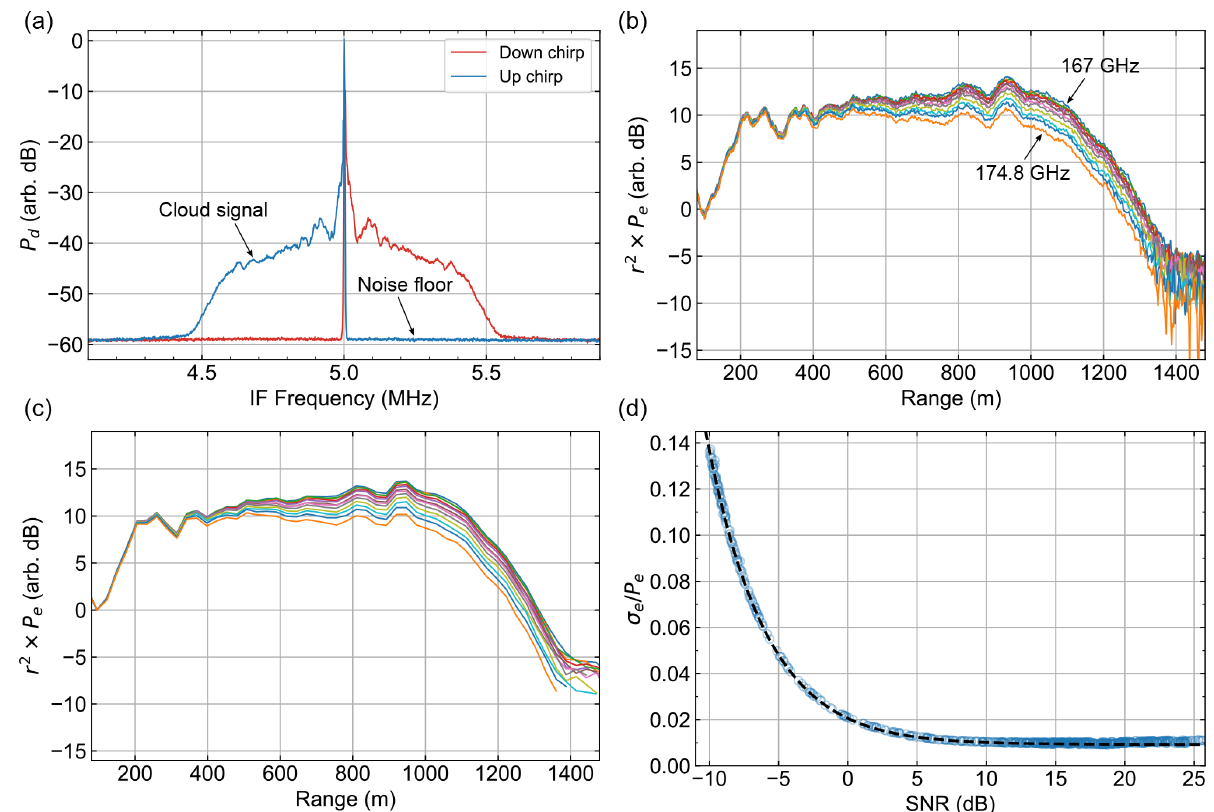
Figure 4. DAR measurement spectra. (a) The bidirectional frequency chirp technique provides for accurate, real-time characterization of the background noise floor within the radar’s IF band, with no loss of measurement duty cycle. Here the detected power spectrum for f j = 167GHz is shown. The IF frequency to range conversion factor is 400kHzkm − 1 . (b) Echo power spectra normalized to their value at 100m for the 12 transmission frequencies. The large variability in the signals near 1.4km indicates the system reaching the noise floor. (c) Echo power spectra after averaging N b = 11 adjacent bins, and filtered for points with SNR > − 10dB. (d) Measurement relative error (blue circles) for all traces in (c) compared with the statistical model (Eq. 8, dashed black